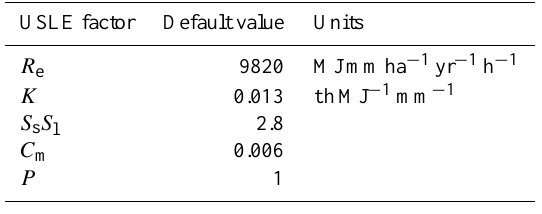
Table 3. USLE factors for a hillslope that has characteristics typical for the Berau drainage basin, including R e derived from rainfall during an average year and C m that represents primary